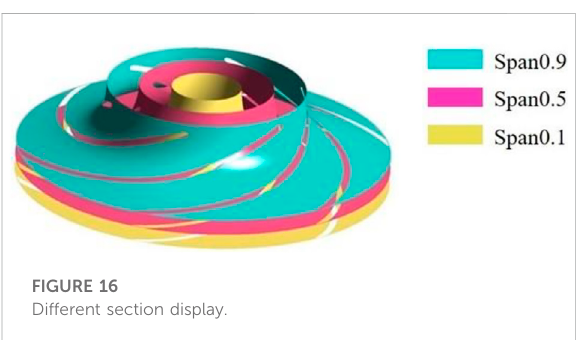
FIGURE 16 Different section